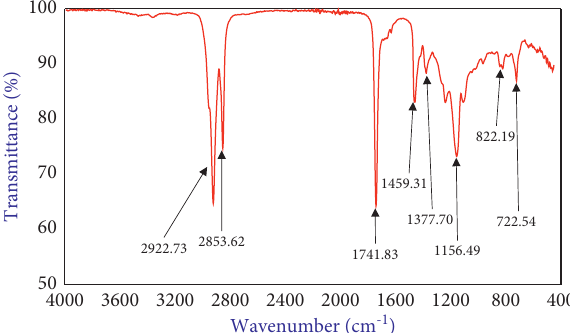
Figure 8: FTIR spectrum of fraction B from the methanol extract of V. camporum .